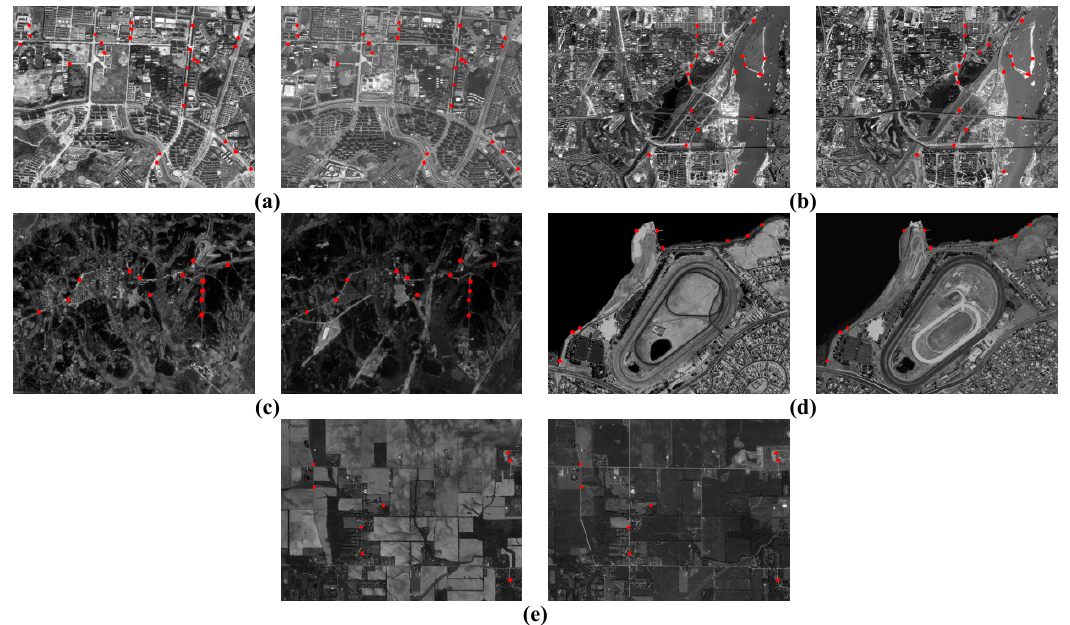
Figure 16. Matching results using Shi’s method [20]. ( a – e ) are the matching results of Pairs 1–5. No correct match is obtained for the image of Pair 6 (i.e., see Table 2).